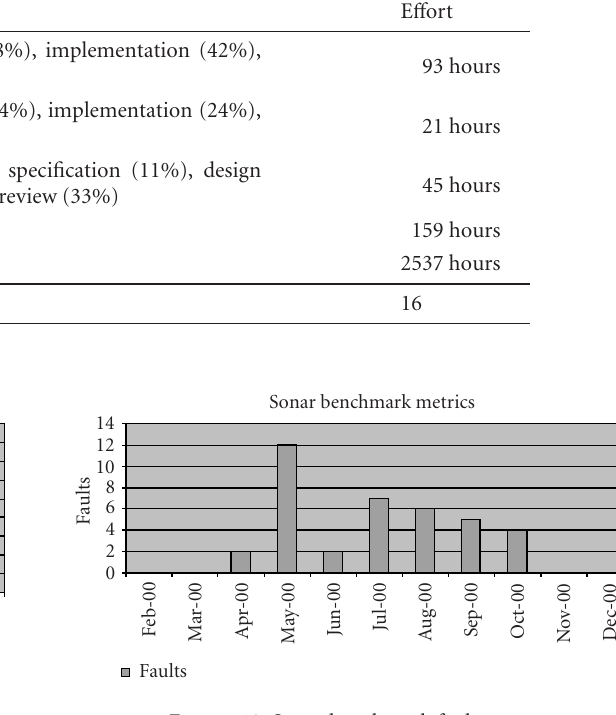
Figure 10: Sonar benchmark fault